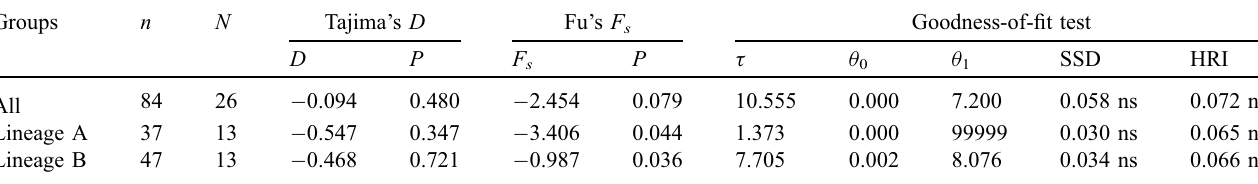
Table 4. Summary of the neutral test and goodness-of- fi t test for P. chinensis . Groups